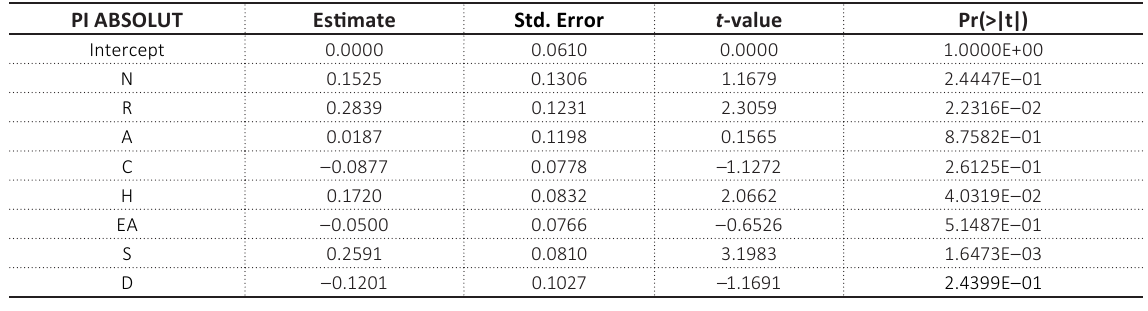
Table 7. PLS PM model output –